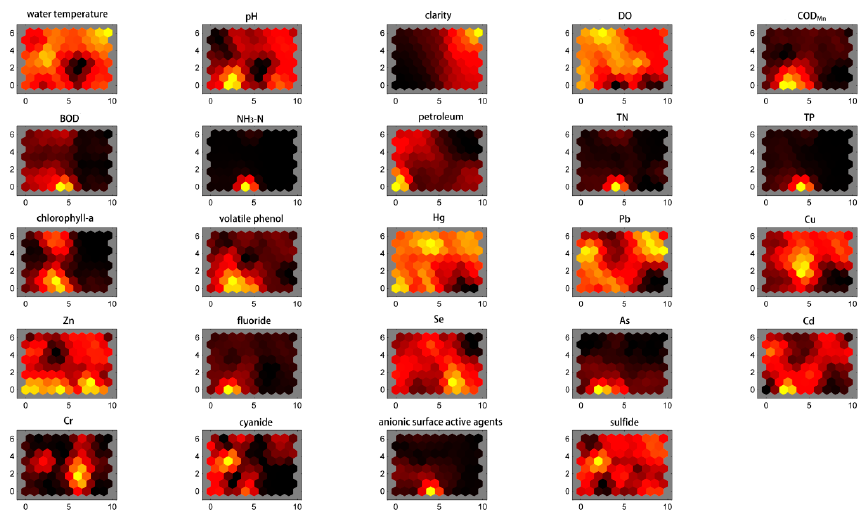
Figure 2. Component planes of the 24 parameters.